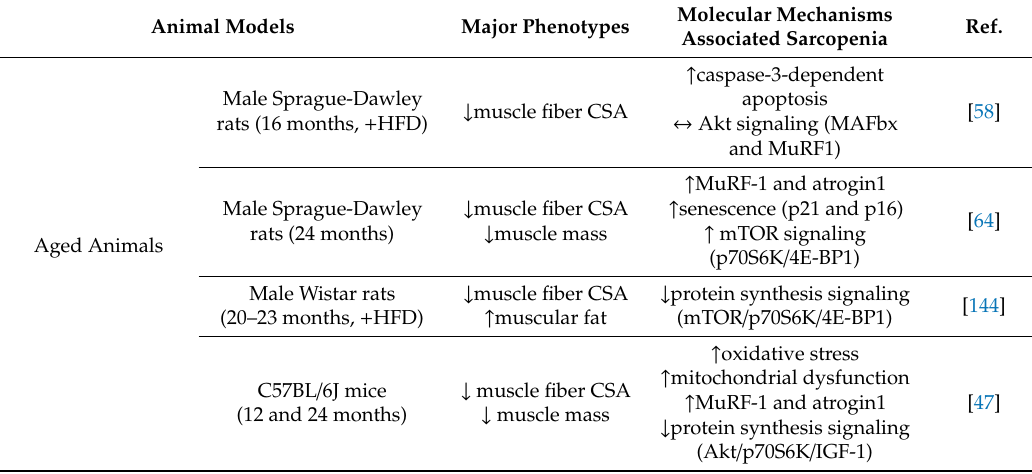
Table 2. Animal models for investigating